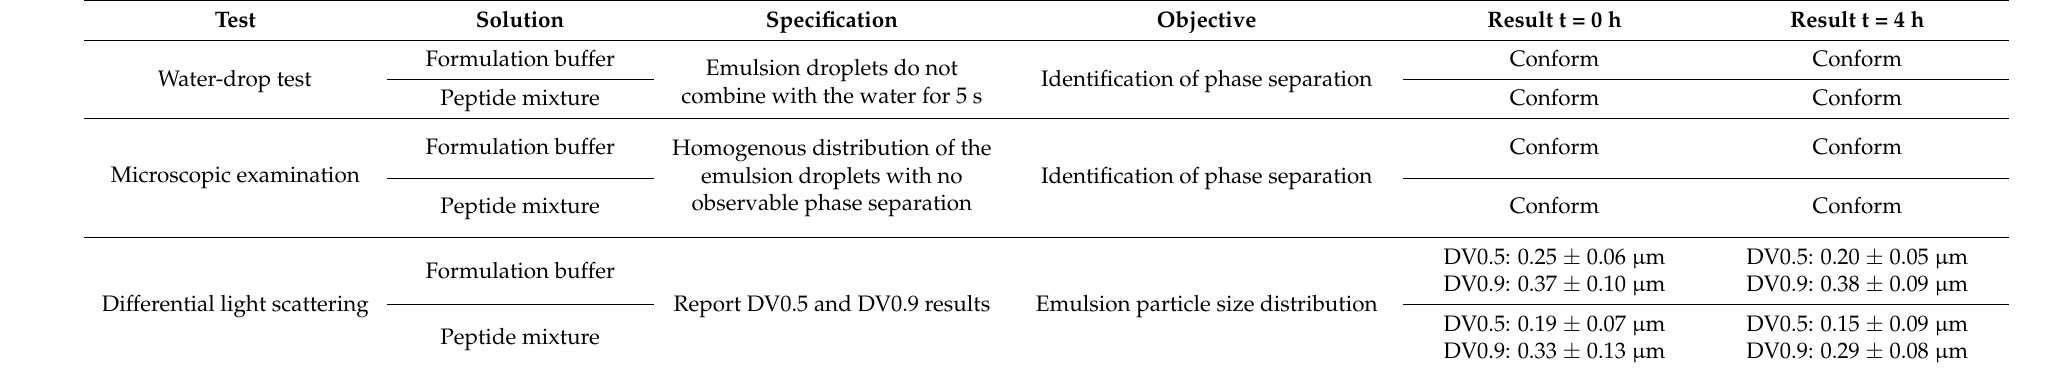
Table 9. The emulsion stability study results. Emulsions were prepared either with the formulation buffer only or the aqueous peptide mixtures that were manufactured under GMP conditions. Analyses were performed in